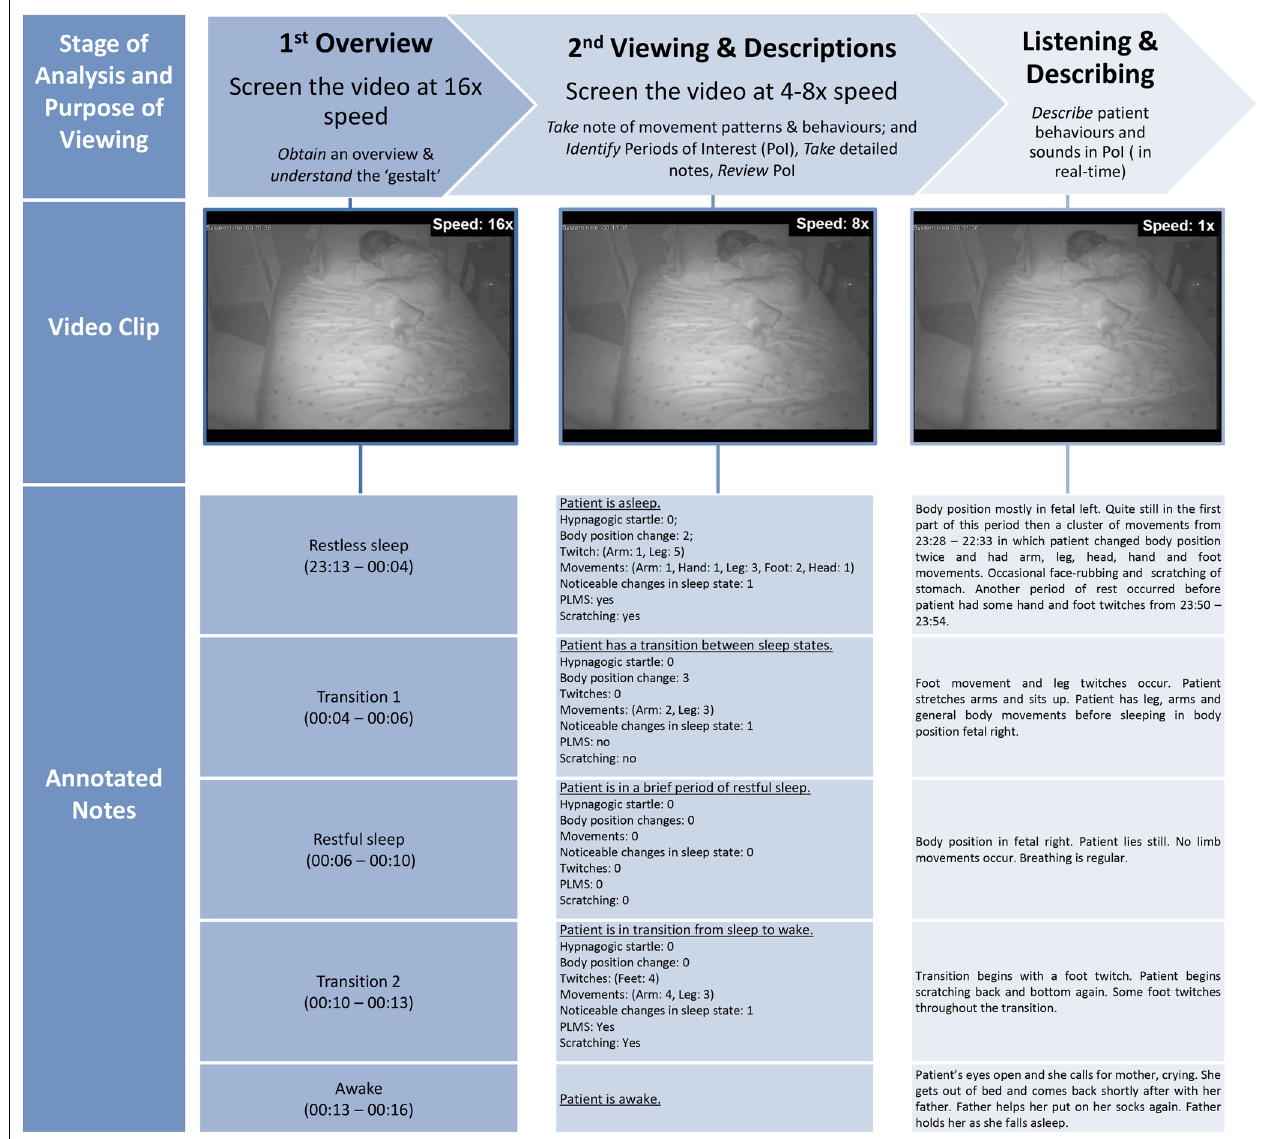
FIGURE 4 | Steps of analysis . This figure shows the analysis process for completed HVS-recordings. The annotated notes describe a sample of the case vignette HVS-recording. The video clip, presented at three viewing speeds, corresponds to the “Transition 2” section of the annotated